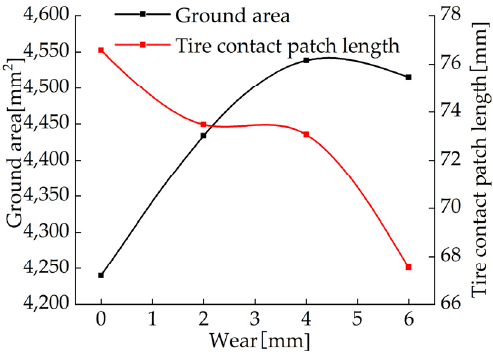
Figure 21. Contact pressure distribution of tire longitudinal contact patch under different wear amounts.